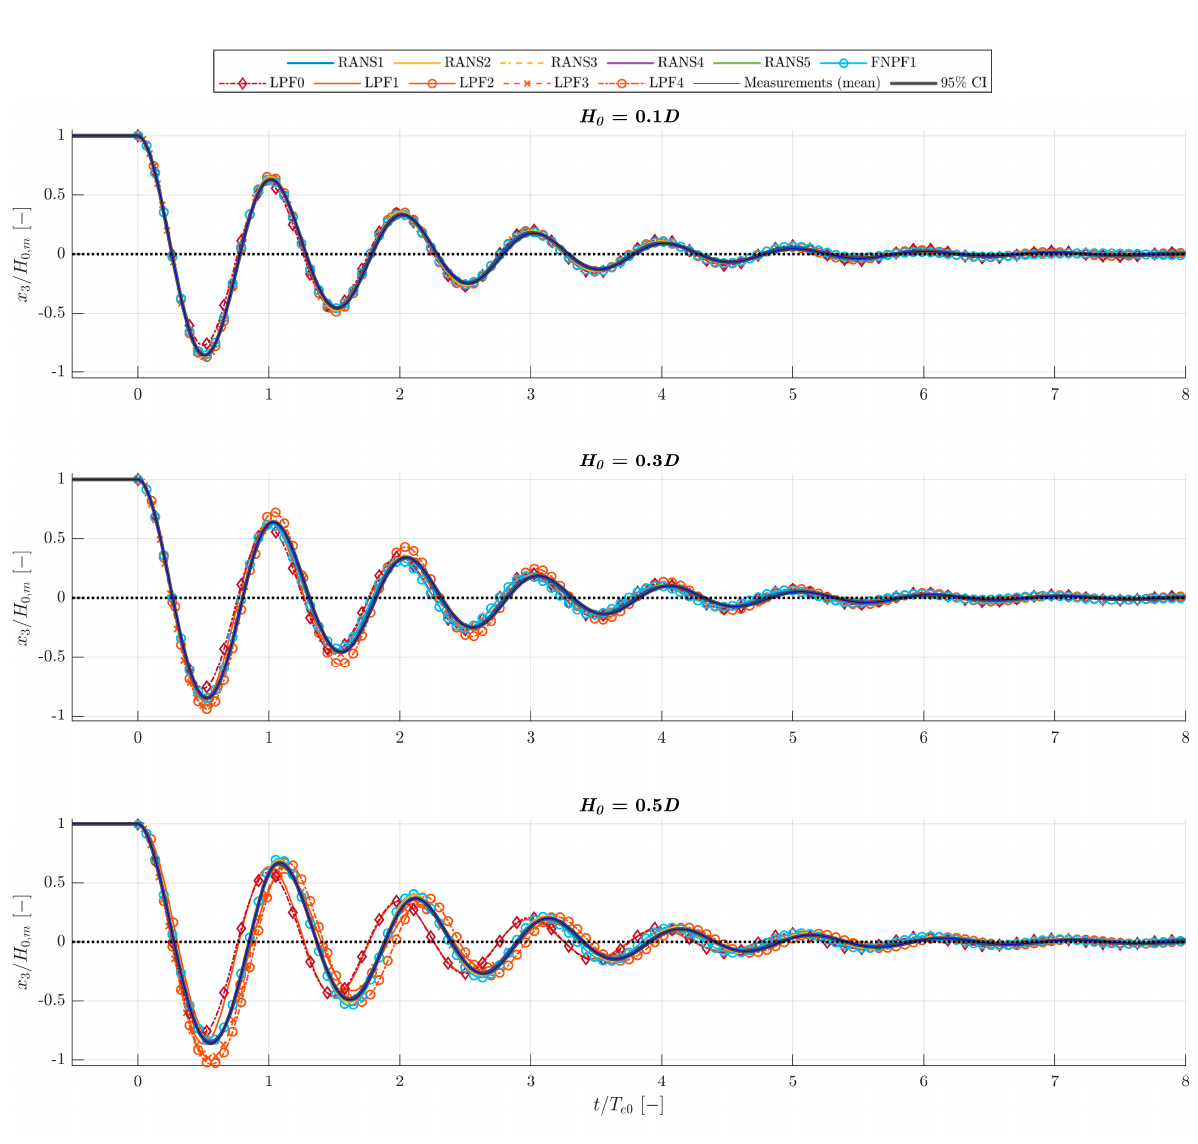
Figure 21. Comparison of physical and numerical test results.